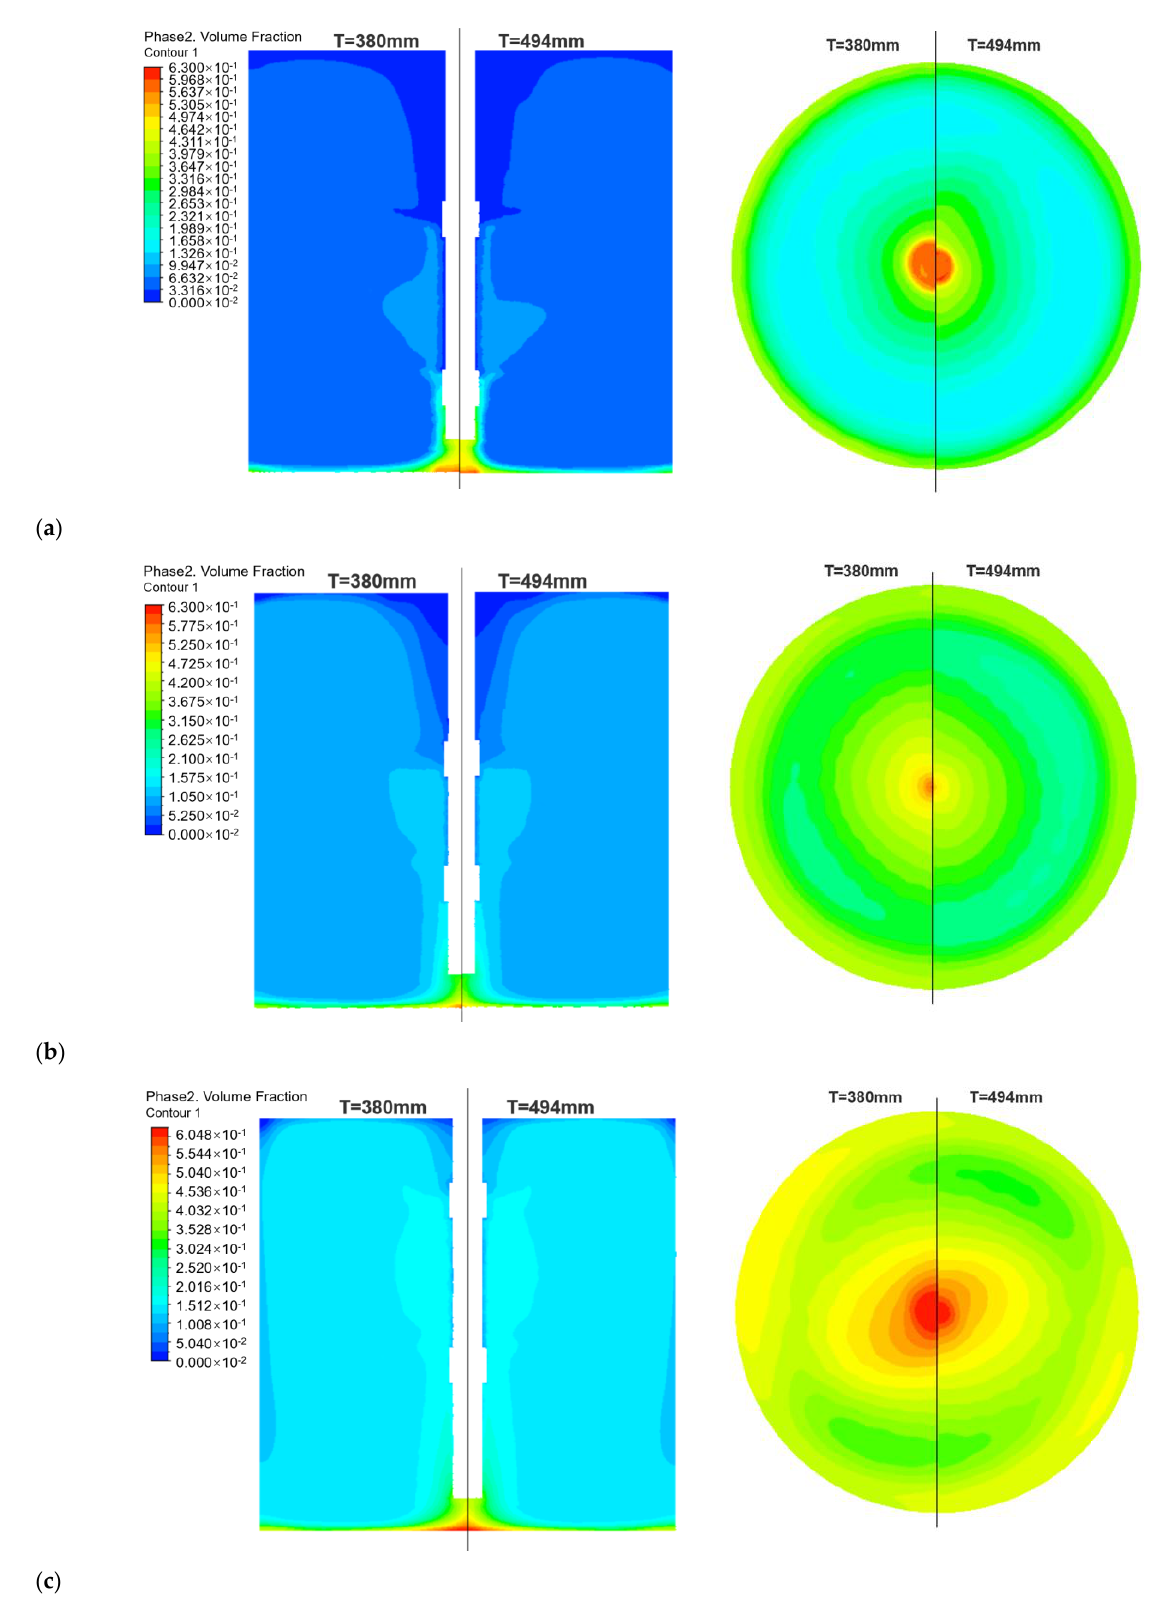
Figure 11. Comparison of solid concentration distribution scaled up based on the same solid suspension degree: ( a ) Co = 5% v/v ; ( b ) Co = 10% v/v ; ( c ) Co = 15% v/v .